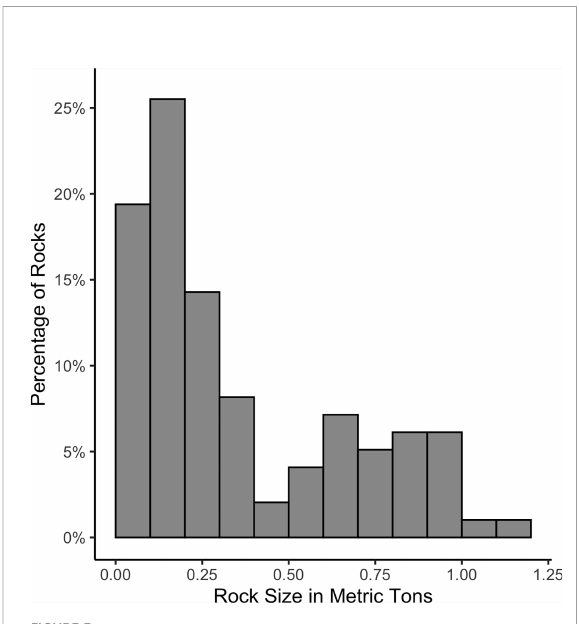
FIGURE 3 Results of rock gradation testing (n=98) from Empire Quarry.